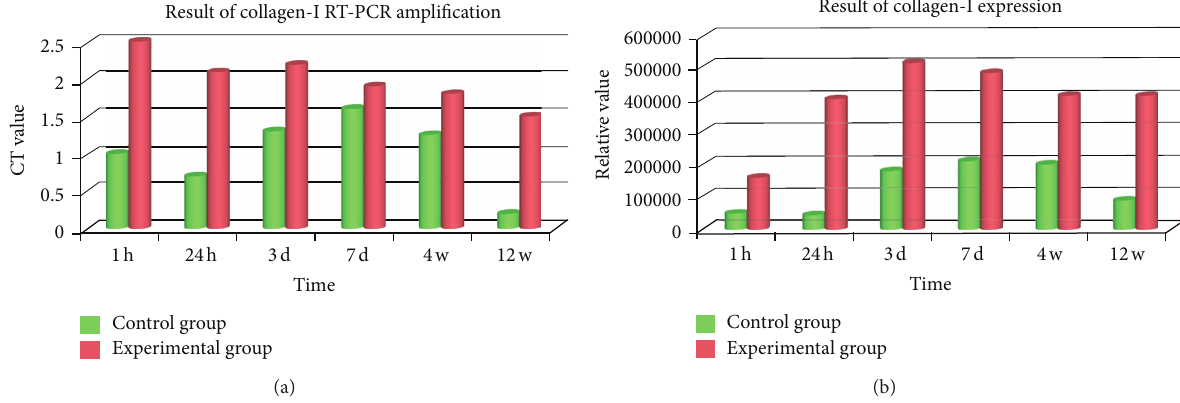
Figure 5: (a) Collagen type I mRNA expression was increased in 1h. A persistent high level was formed in postoperative 24 h to 3d. Despite being slightly descended in 7d, it kept a comparative high expression from 4w to 12 w which was remarkably higher than that of control ( 𝑃 < 0.01 ). (b) A high protein expression of Collagen type I was detected in 3 d, 7 d, and 4 w. The expression of 12w descended considerably compared to 4 w with significant difference ( 𝑃 < 0.01